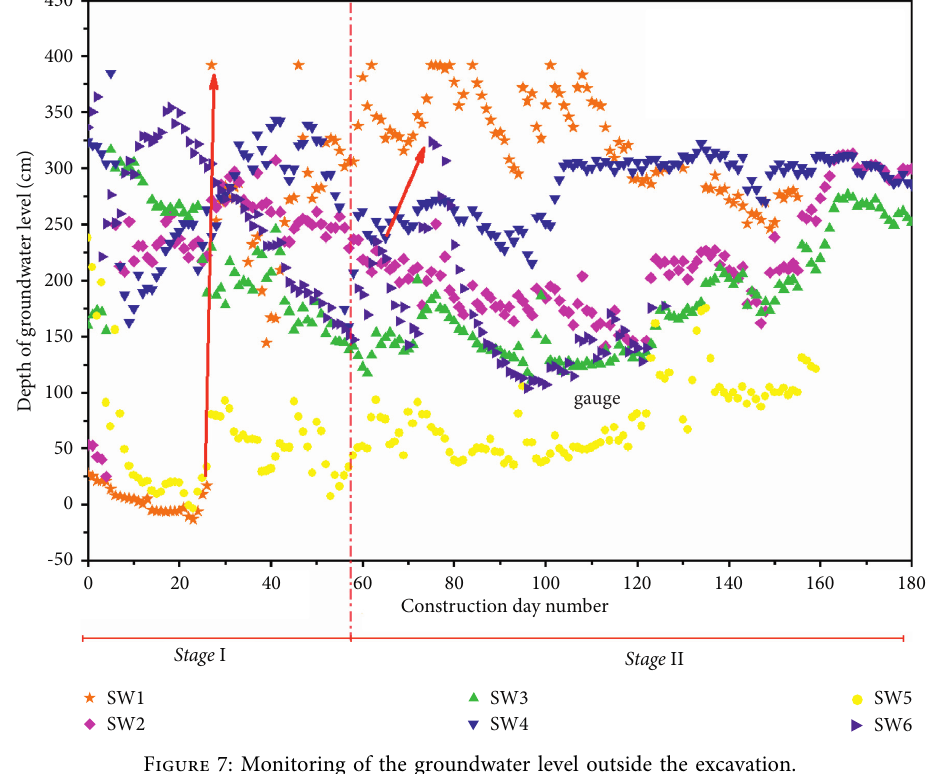
Figure 7: Monitoring of the groundwater level outside the excavation.